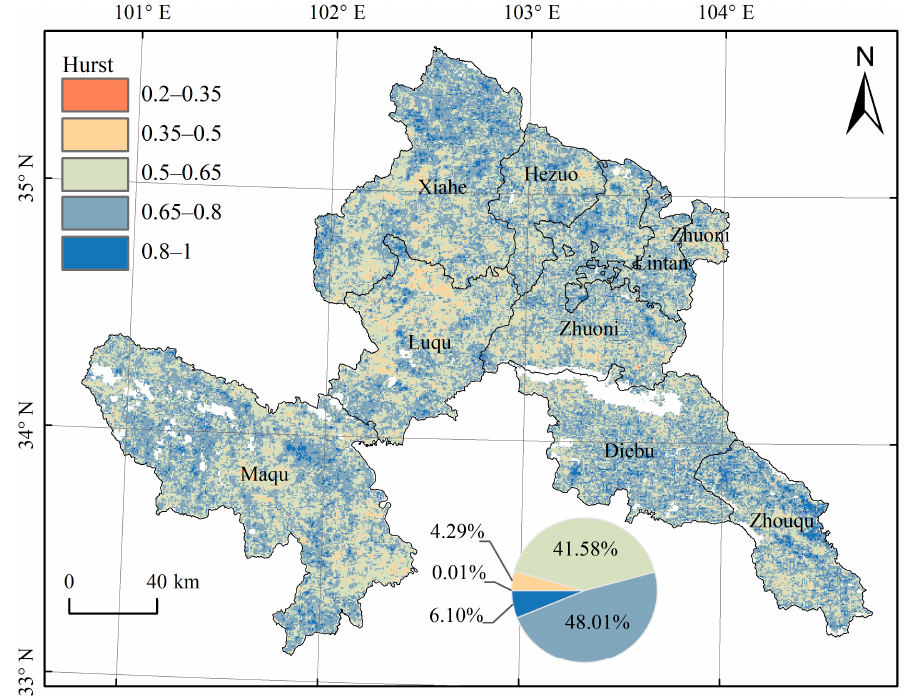
Figure 4. Spatial distribution and statistics of the Hurst index according to NDVI time series.